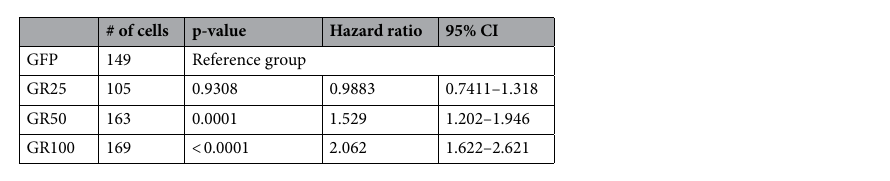
Table 2. Statistical assessment of motor neuron